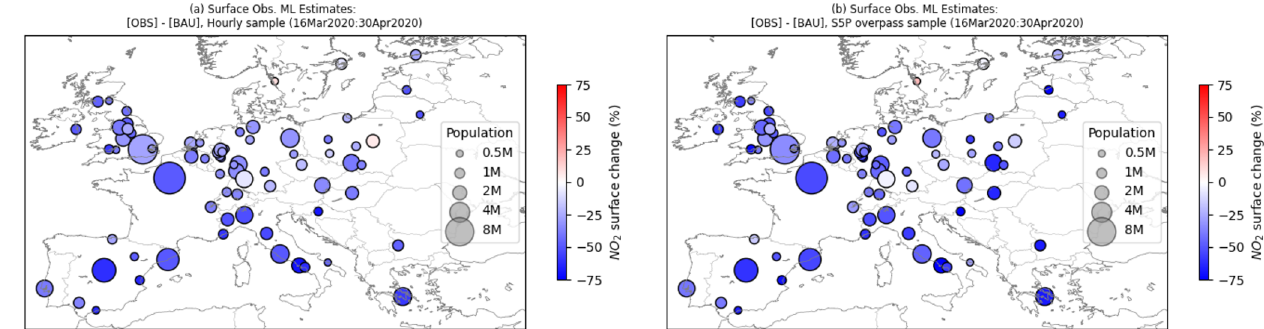
Figure 7. Weather-normalized estimation of NO 2 changes (%; relative to the BAU predictions) using surface observations during the lock- down period using business-as-usual (BAU) simulated observations as the baseline for urban areas with at least 0.5 million inhabitants. Panel (a) shows the estimates using full hourly datasets, and panel (b) shows the estimates using the S5P-sampled overpass time dataset. The diameter of the circles is proportional to the population in each urban area. Table 3. Performance of the ML predictions of hourly NO 2 surface mixing ratios over all European urban areas included in the dataset.